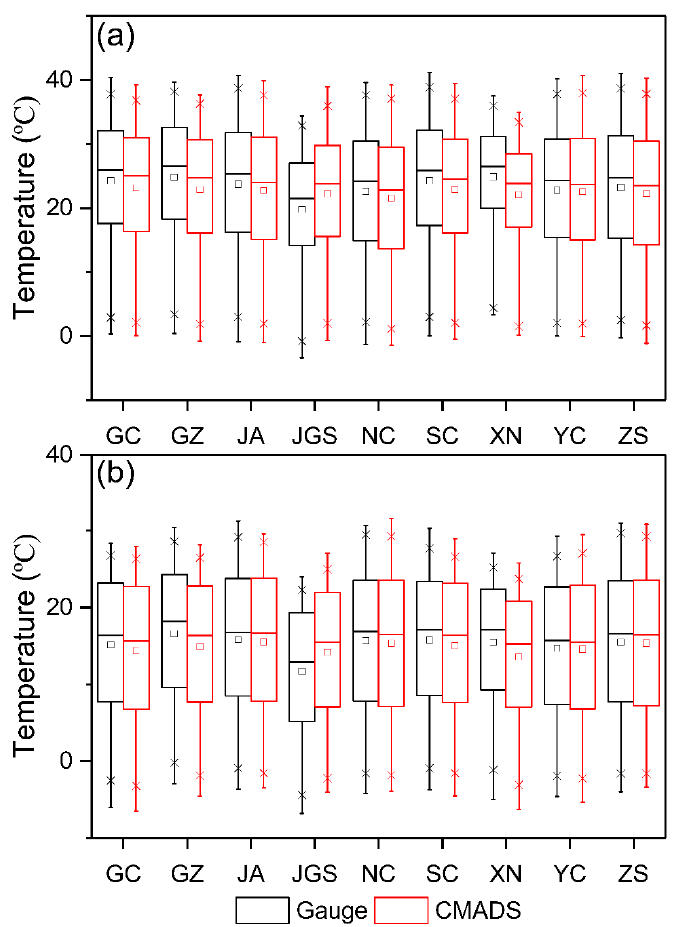
Figure 4. Box plots of temperature estimated from meteorological gauges and CMADS in the GRB for ( a ) daily maximum temperature and ( b ) daily minimum temperature (GC: Guangchang; GZ: Ganzhou; JA: Jian; JGS: Jianggangshan; NC: Nanchang; SC: Suichuan; XN: Xunnian; YC: Yichun; ZS: Zhangshu, shown in Figure 1).